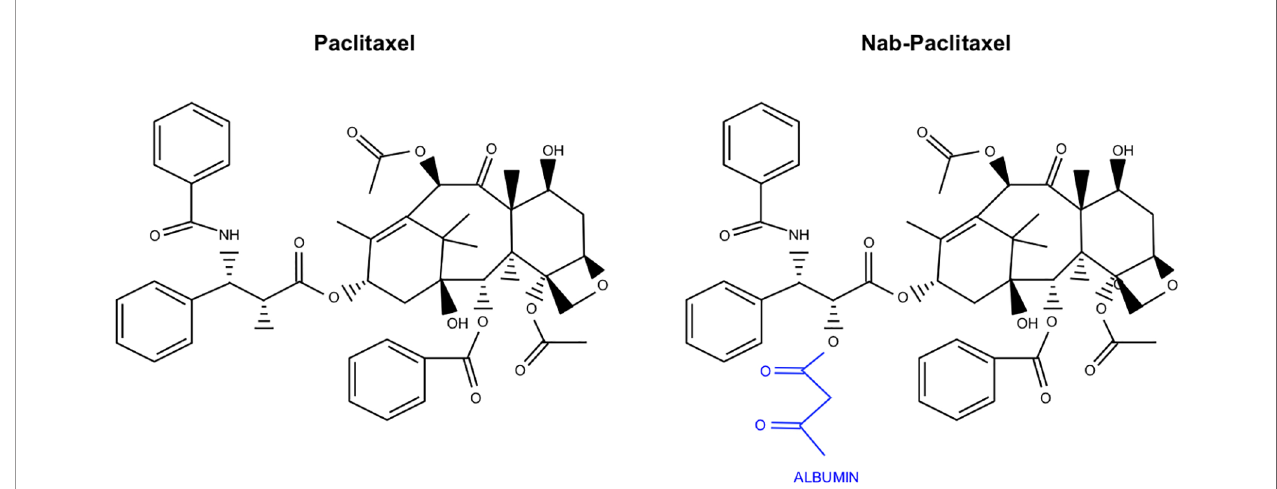
FIGURE 5 | Chemical structure of Paclitaxel and the albumin conjugated variant Nab-Paclitaxel. Nab-Paclitaxel, used in combination with Gemcitabine in PDAC, varies from Paclitaxel in that it is conjugated to albumin as a delivery